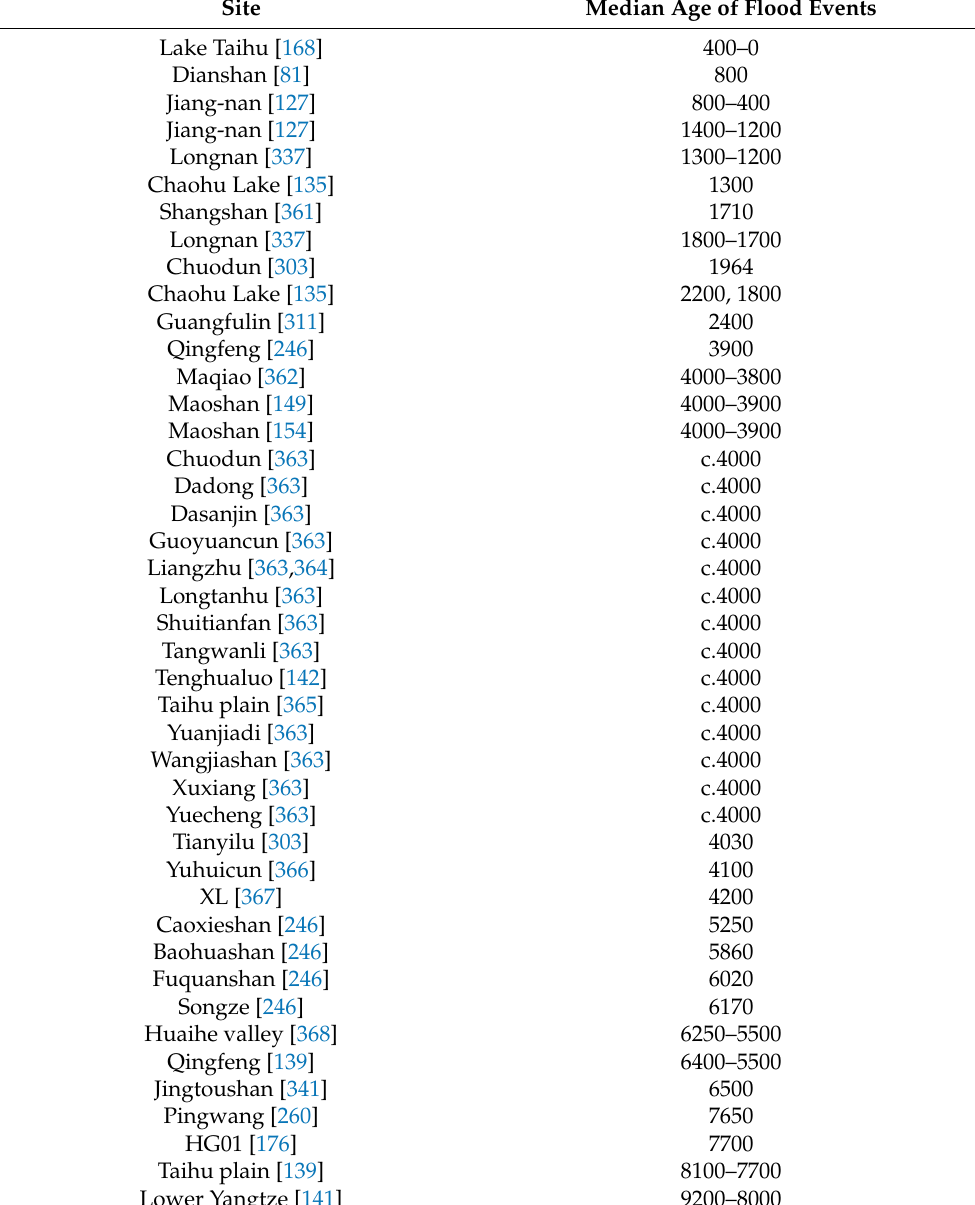
Table 3. Chronology of Holocene fluvial flood events (rapid water level rises) in the Taihu low- land/lower Yangtze area. Dates are in calibrated years BP. Age ranges may include several dates. Some dates are reliable estimates based on other